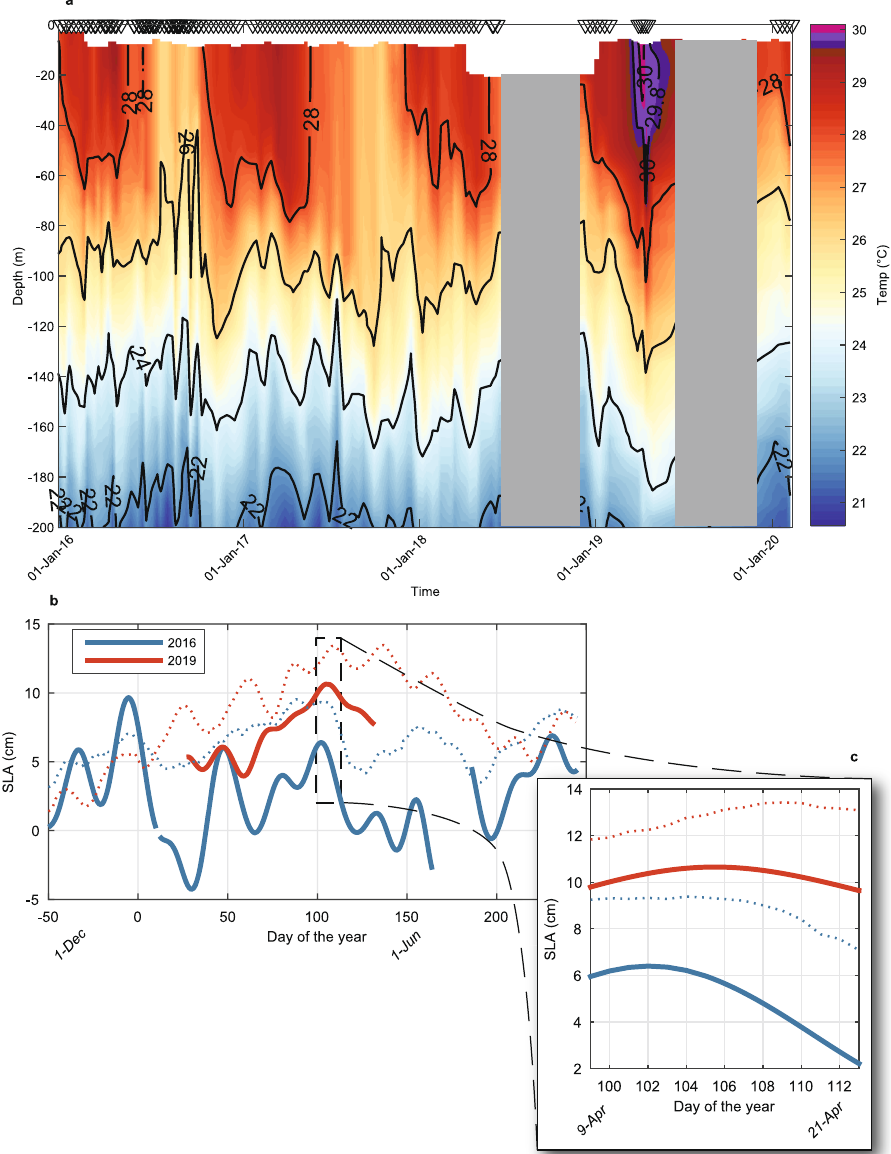
Fig. 7 | Evidenceofisotherm deepeningand sealevelelevationaroundMoorea during the 2019 subsurface marine heatwave. a Broad-scale vertical thermal structure based on Argo and WOD casts around Moorea highlight isotherm dee- pening (black lines shown for every 2°C) and surface layer heating during early 2019, with the coral bleaching threshold (29.8°C) visible in the surface 50m (periodswithoutcastsaregreyedout).Comparisonof b thesealevelanomaly(SLA